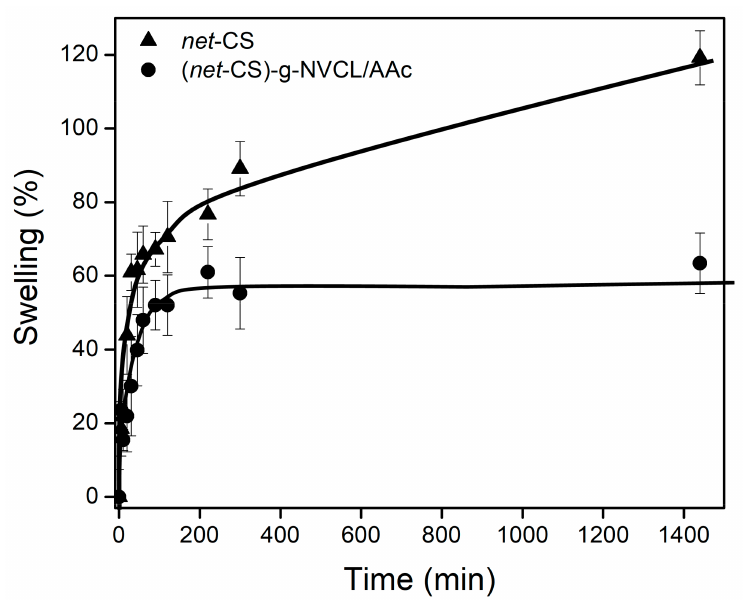
Figure 6. Equilibrium swelling in water of ( (cid:78) ) net -CS and ( • ) ( net -CS)- g -NVCL/AAc (32% graft) at room temperature.